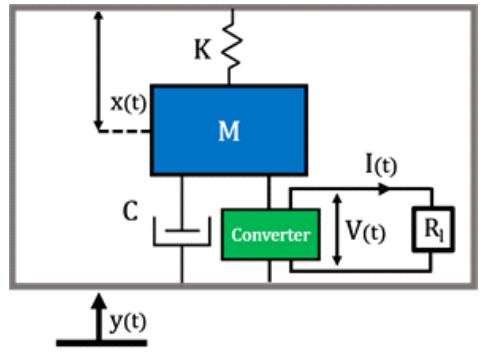
Figure 1. Schematics of the kinetic energy converter.